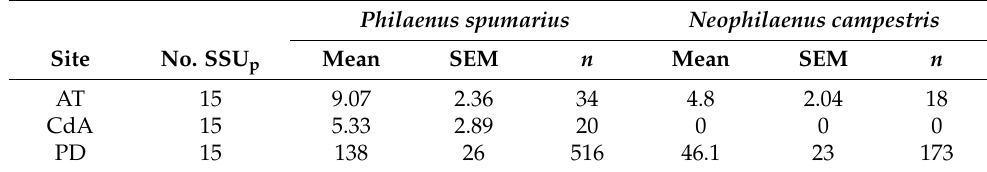
Table 3. The abundance of spittlebug nymphs (total and mean individuals/m 2 ) on herbaceous cover of inter-rows in three organic Piedmont vineyards (AT = Asti, CdA = Cisterna d’Asti, PD = Paderna) in 2018.